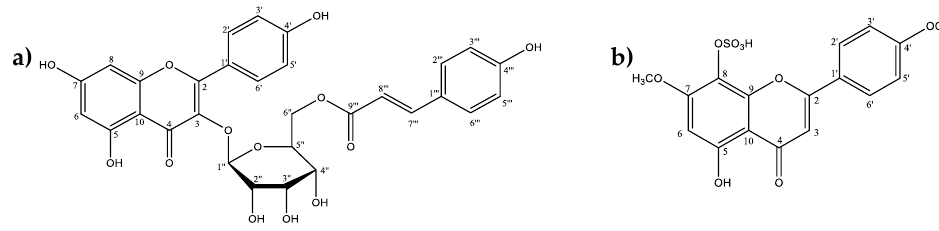
Figure 5. Substances selected after virtual screening for in vitro testing: ( a ) Tiliroside; ( b ) 7,4′-di- O - methyl-8- O -sulphate flavone .